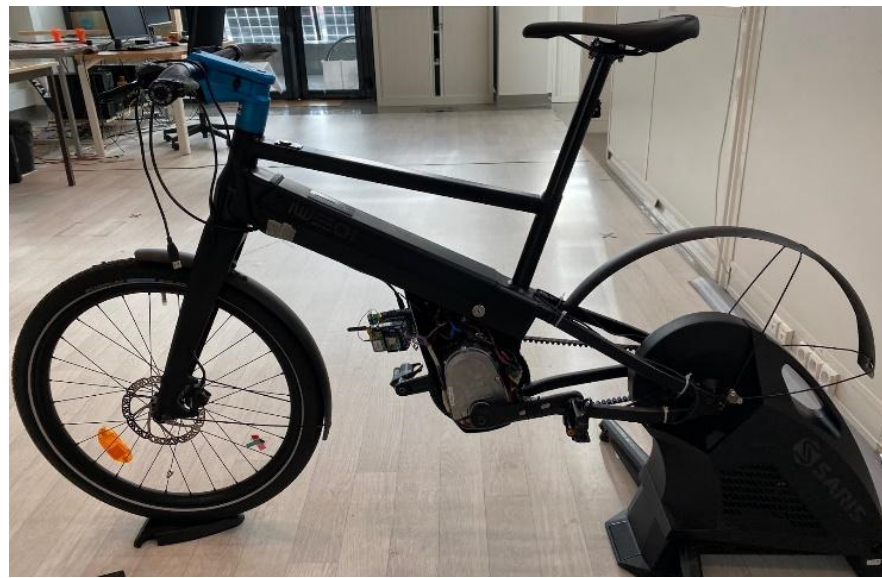
Figure 5. Screen captures from the application.